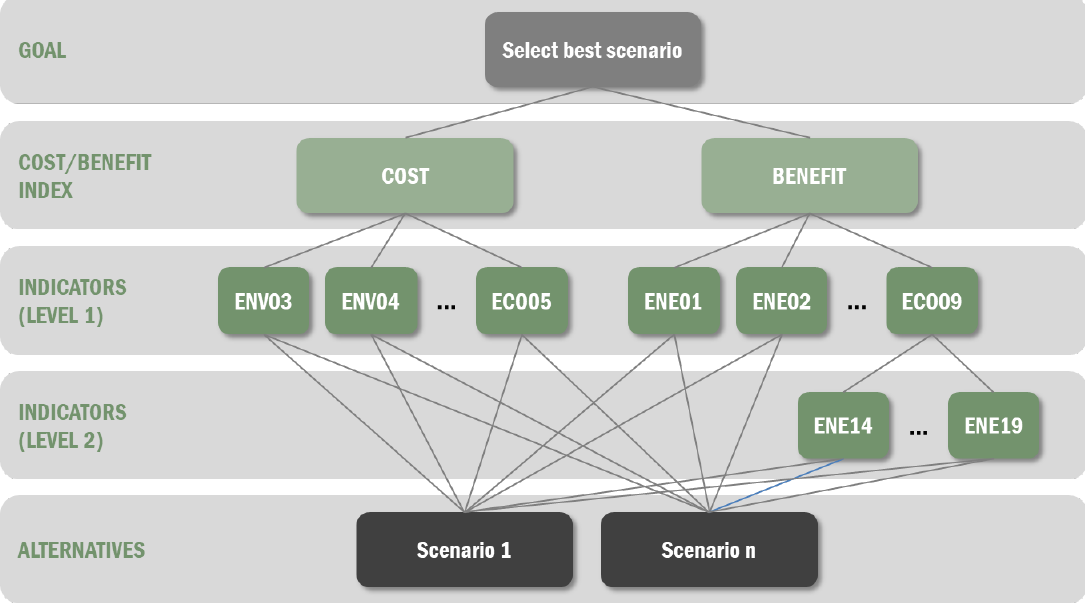
Figure 3. Hierarchy for the decision-making process.